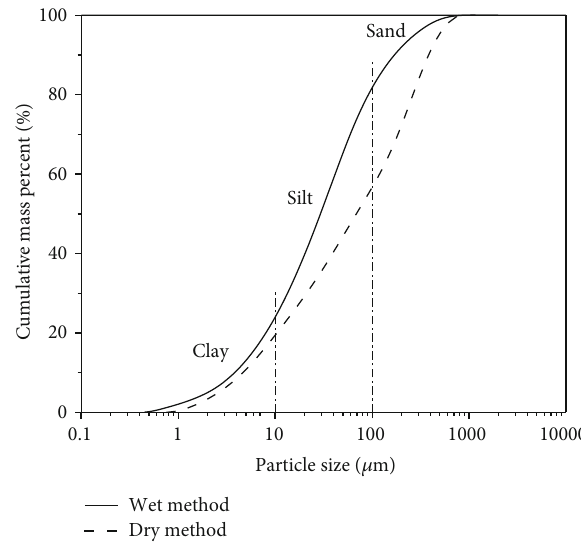
Figure 2: Particle size distributions of Karamay oil